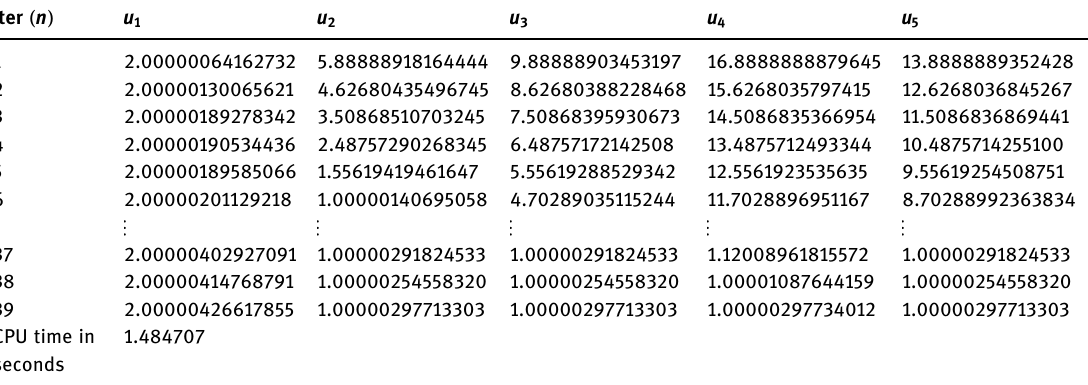
Table 2: Example 5.2: Numerical study of Algorithm 1 in [ 29 ] with TOL = 10 −4 and u